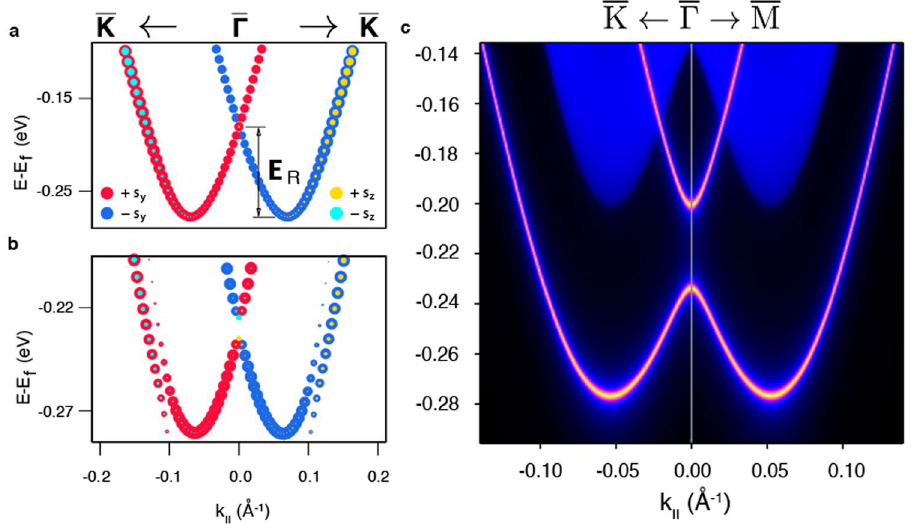
Figure 3. Ab initio and tight-binding calculations of pure and V-doped BiTeI. ( a ) Spin-resolved DFT-calculated (0001) surface band structure of pure BiTeI, projected onto the Te-terminated surface TL block. ( b ) The same as ( a ), but for the V-doped BiTeI case. The size of the circles reflects the module of the respective spin projection in each k -point. Note, that in ( a ) E F is as calculated for the H-passivated slab (see Methods Section). For the clear comparison, in ( b ) we shift E F to the position corresponding to the undoped case. The artificial discontinuity of the outer branches of the Rashba-split state in b (~|0.1| Å) stems from the crossing with the quantum well state localized in the subsurface TL (see Supplementary Information). ( c ) Tight-binding calculated surface bandstructure of V-doped BiTeI in the presence of point defect (see